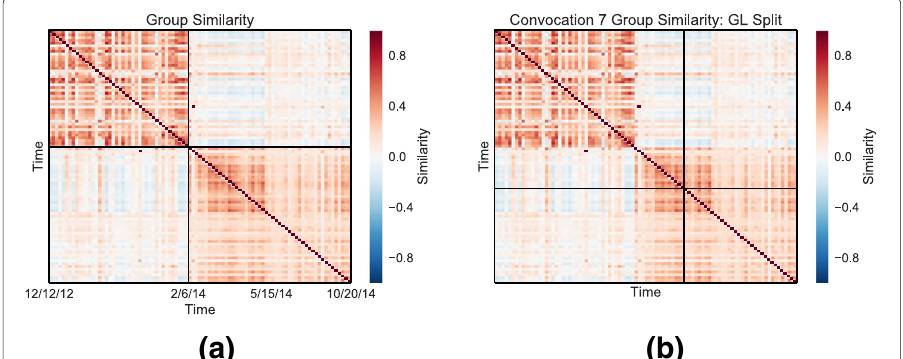
Fig. 1 The Rada’s temporal similarity matrix for convocation 7, created using Louvain grouping. The temporal partition found with our method is drawn in black in ( a ), and occurs on February 6, 2014, which is the start date of the Ukrainian Revolution. The best-fit generalized Louvain partition is shown in ( b ), and occurs on April 4,